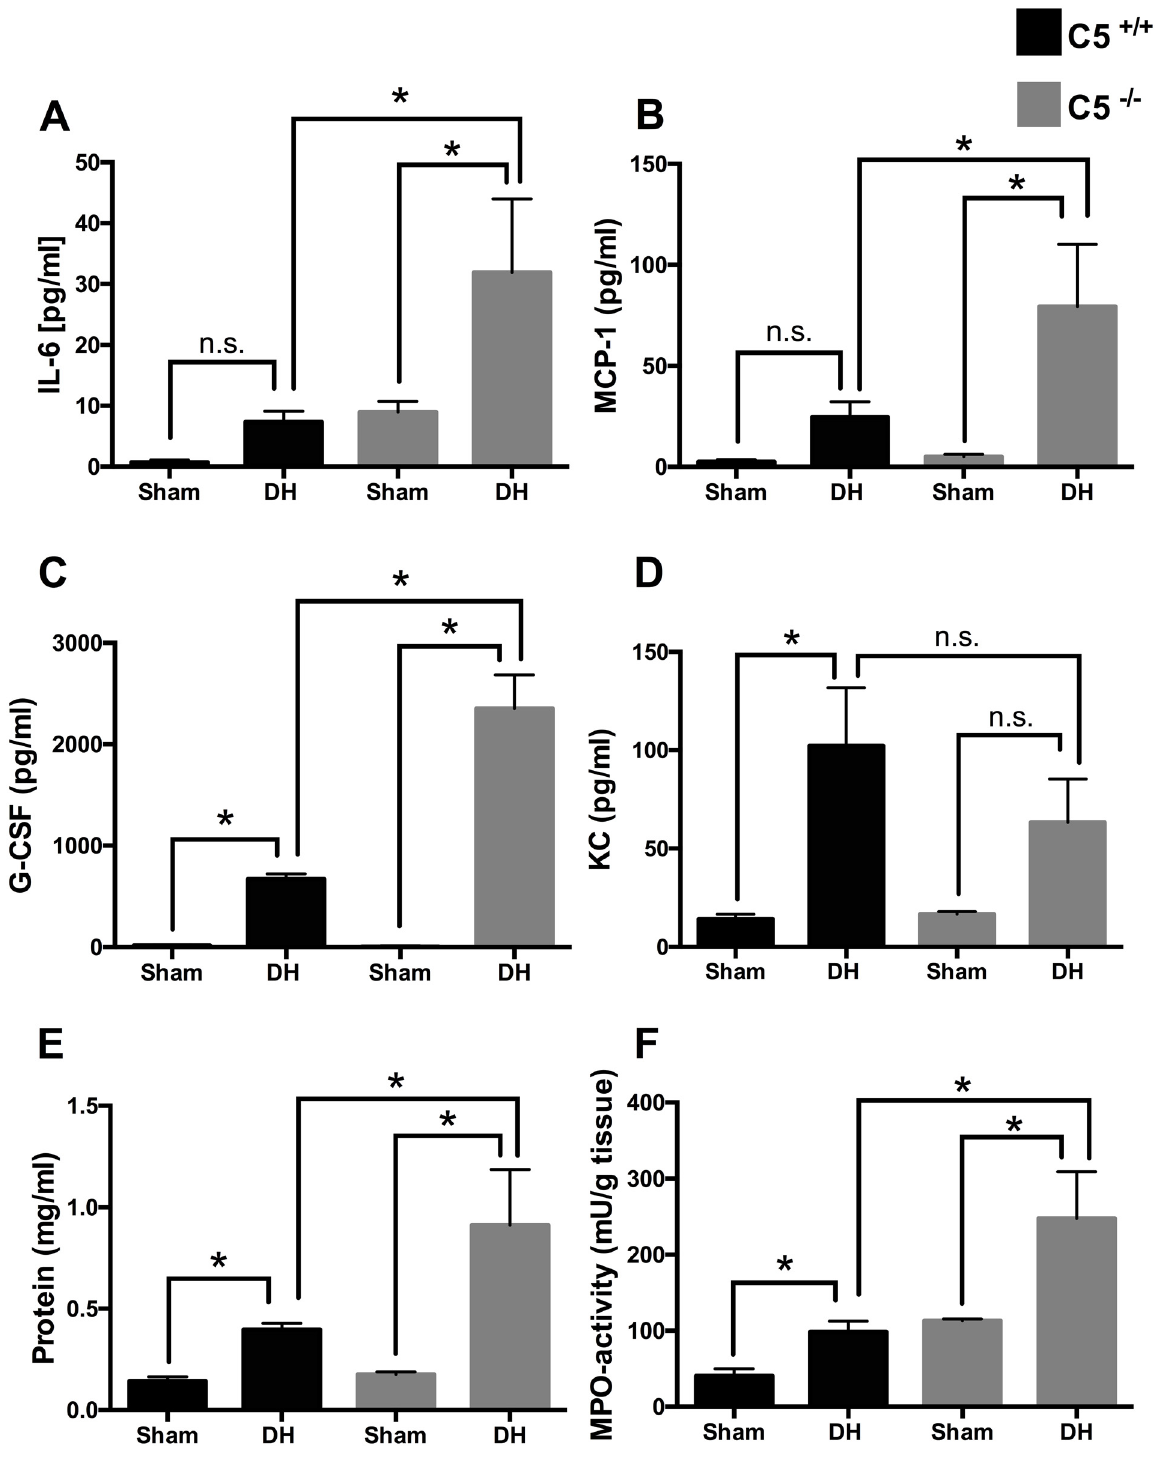
Fig 3. Bronchoalveolar lavage fluid (BALF) cytokine, chemokine and protein concentrations in mice after sham procedure or double hit (DH) in C5 +/+ (wt) mice (black bars) and C5 -/- mice (grey bars) and MPO activity in lung tissue. Increased IL-6 BALF concentration in C5 -/- mice after DH compared to sham and compared to DH in wt mice. B . Increased MCP-1 levels after DH in absence of C5 compared to sham and compared to DH in wt mice. C . Increased G-CSF BALF concentration after DH in presence and absence of C5. Further increase of G-CSF concentration after DH in absence of C5 compared to wt. D . Increased KC levels in